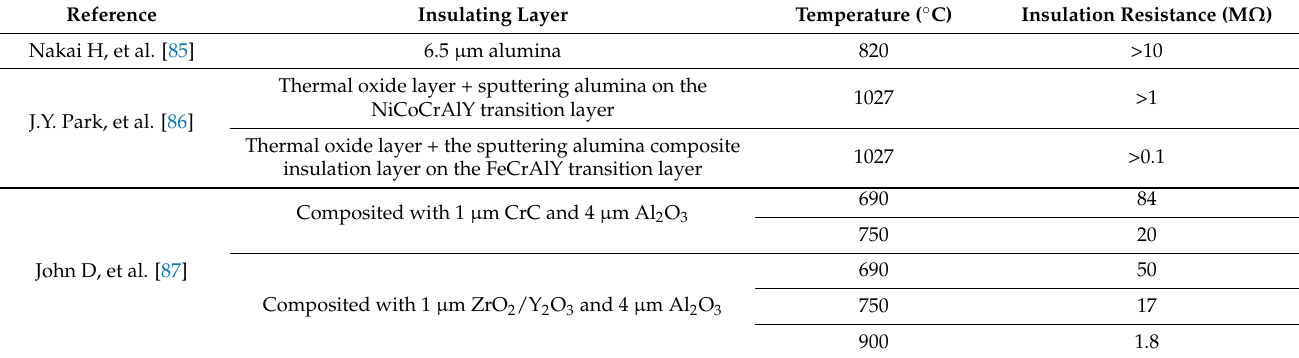
Table 4. High-temperature characteristics of different insulating materials for metal coils.